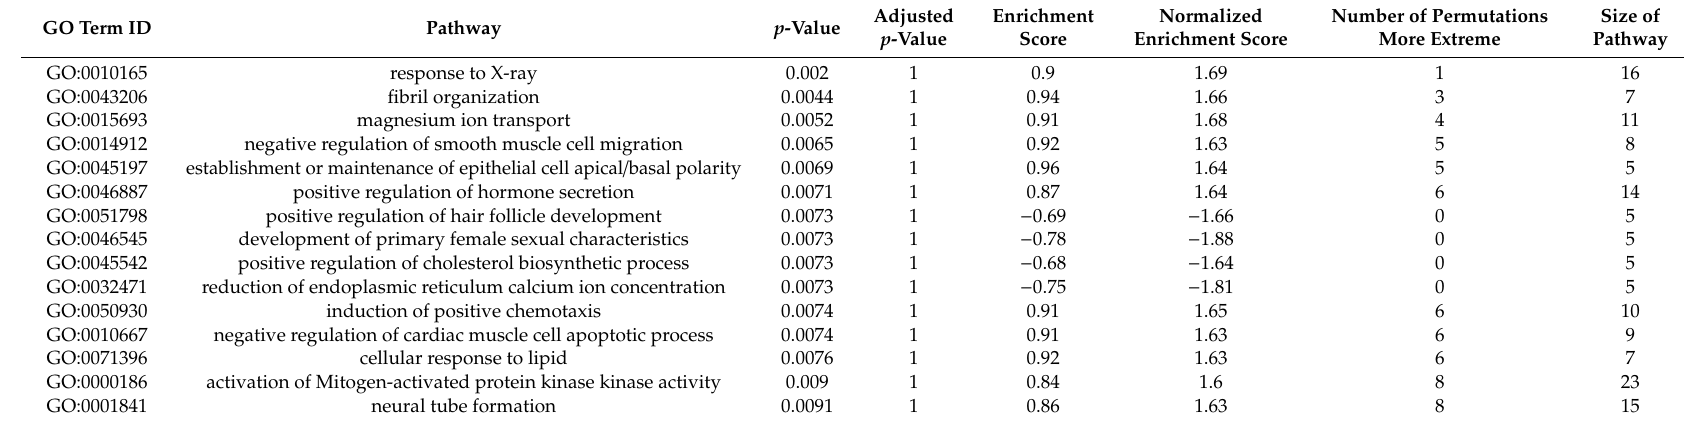
Table 1. Top gene ontologies enriched among di ff erentially methylated genes associated with high perinatal Pb exposure (32 ppm) relative to control treated mice.